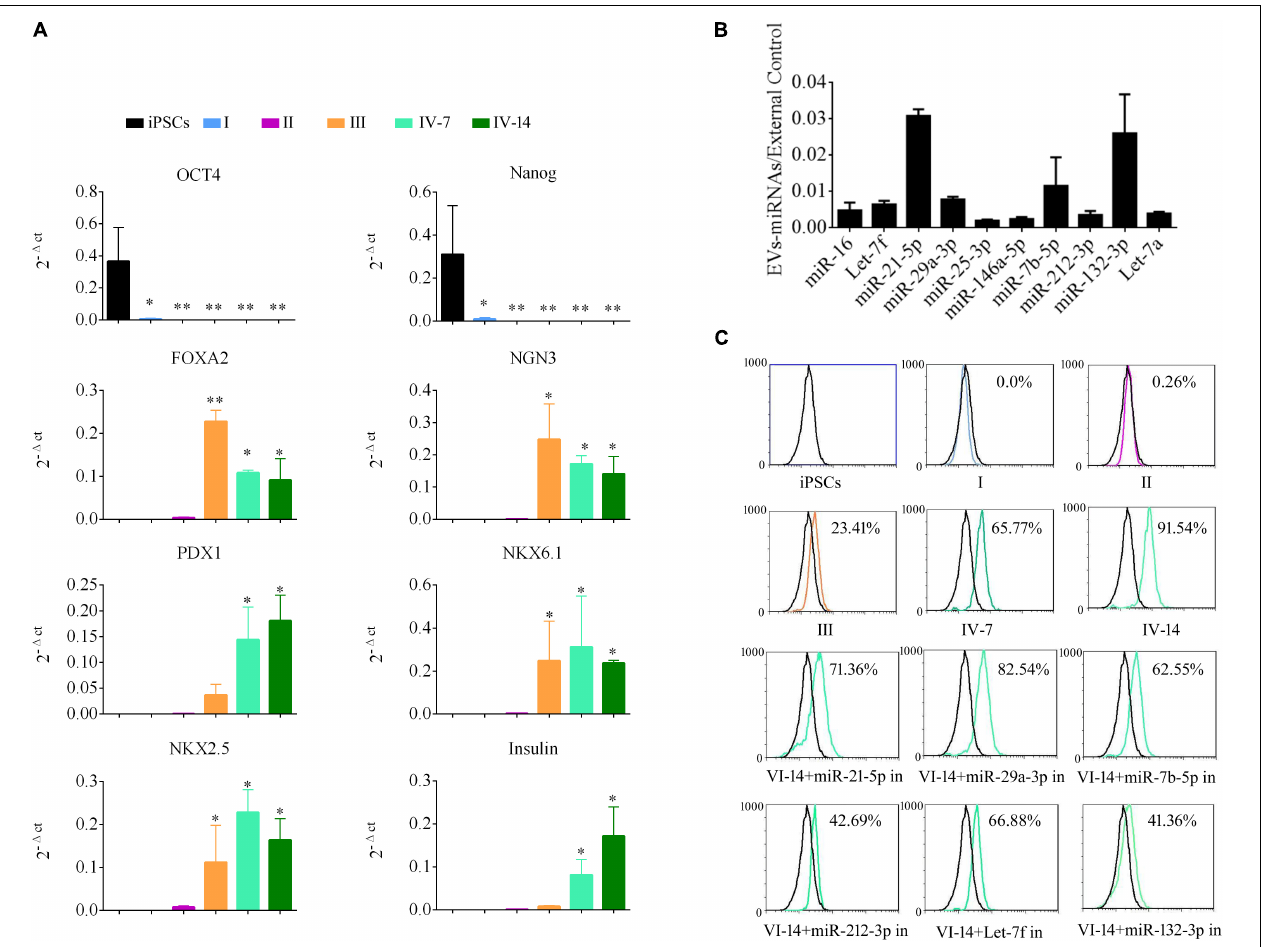
FIGURE 5 | EV-carried microRNAs promote the differentiation of i-Beta cells from iPSCs. (A) Gene expression of iPSCs at various stages of differentiation compared with control iPSCs. Data are expressed as the mean ± SD of three independent experiments ( n = 3). ∗ p < 0.05, ∗∗ p < 0.001 relative to control iPSCs. (B) The abundances of the top 10 miRNAs in EVs were verified by qPCR and expressed as the fold change versus the external control ( n = 3). (C) Flow cytometric analysis of insulin expression during each stage of differentiation. Five miRNAs were selected from the top 10 miRNAs to analyze their roles in the formation of i-Beta cells from iPSCs. Insulin-positive cells were significantly decreased after addition of miR-212-3p and miR-132-3p inhibitors. in: miRNA